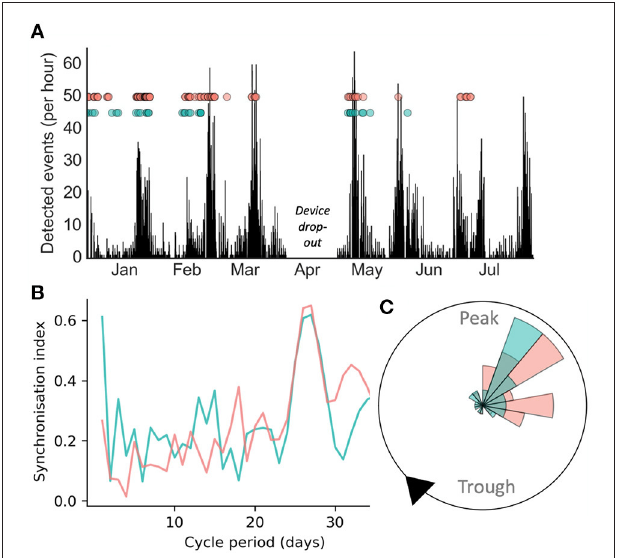
FIGURE 1 | Case study of electrographic seizure detection from sub-scalp EEG (red) and seizure diary self-reported events (green) over > 6 months in an individual patient. (A) : counts of detected epileptiform events over time, with seizures shown as dots. (B) Synchronisation index measured from event times at different fixed cycle periods showed a similar peak around 28-days for both EEG and self-reported seizures (C) A polar plot demonstrating that both diary and EEG seizures show similar phase distributions with respect to the underlying 28-day